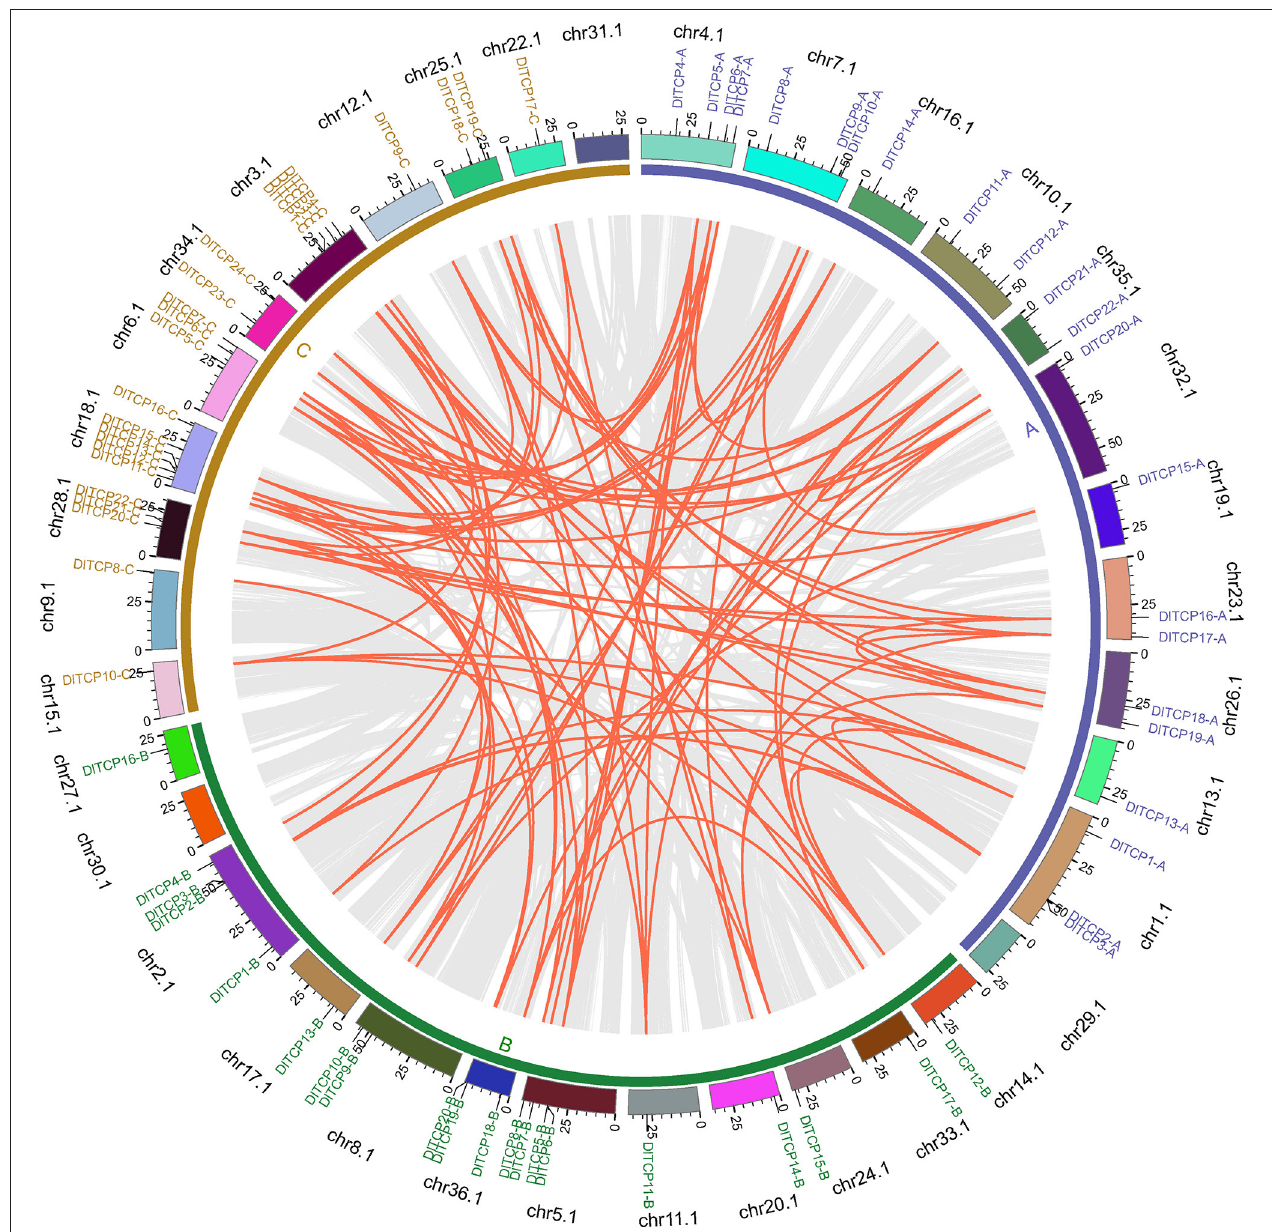
FIGURE 3 | Chromosome distribution and synteny analysis of TCP genes in Ma bamboo. Different chromosomes were showed in different colors. The inner gray lines were used to mark all the collinearity relationships in Ma bamboo and the inner red lines were represented the collinearity relationships of TCP members in Ma bamboo. Gene names of different colors were used to mark the TCP members from different